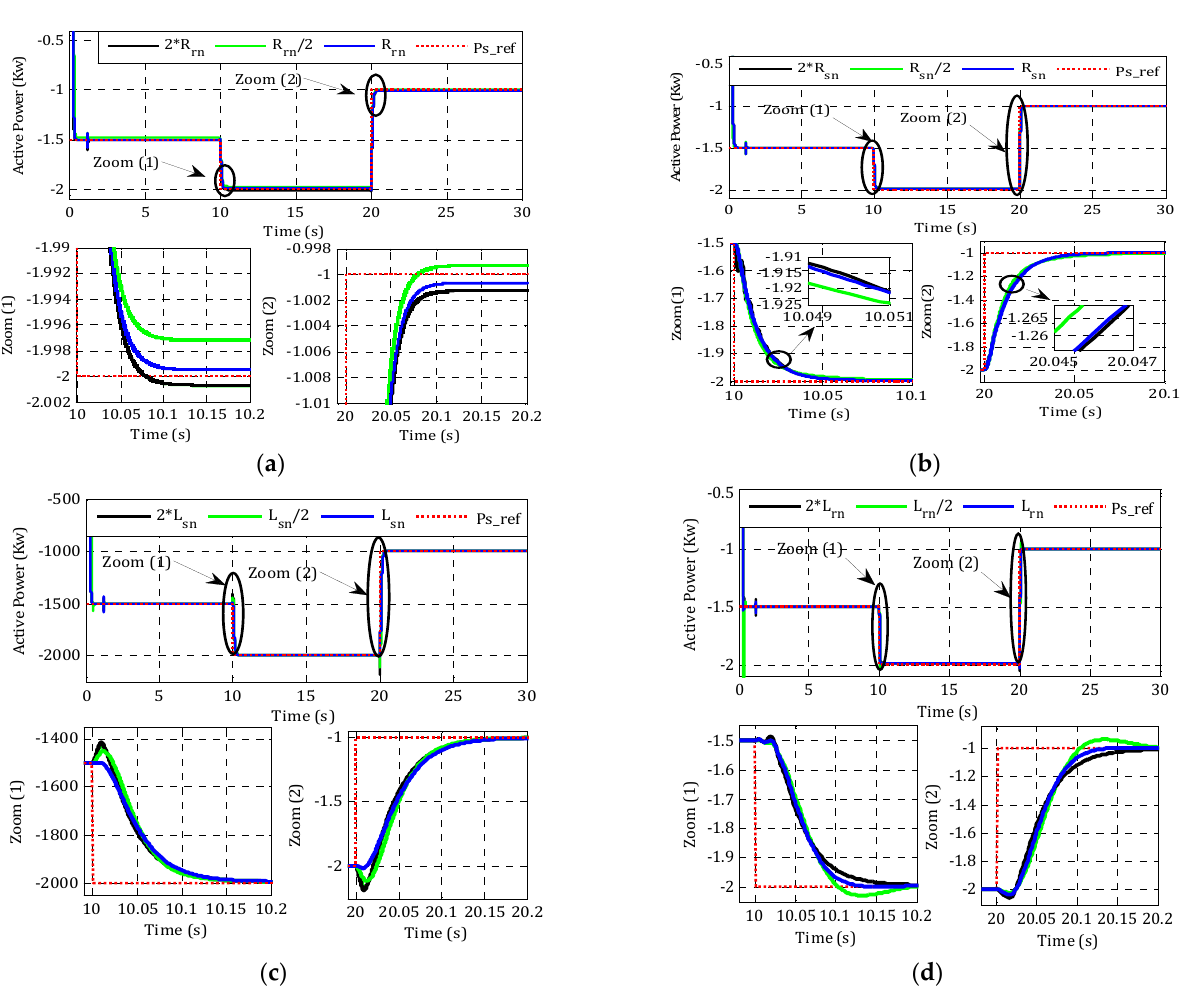
Figure 6. Co-simulation experimental results robustness, ( a ) Active Power with 2*Rn, ( b ) Active Power with Rn/2, ( c ) Active Power with Lsn/2. ( d ) Active Power with Lrn/2. To demonstrate the advantages and the superiority of the proposed control it is in- teresting to compare it with other techniques in the literature. It is noted here that these